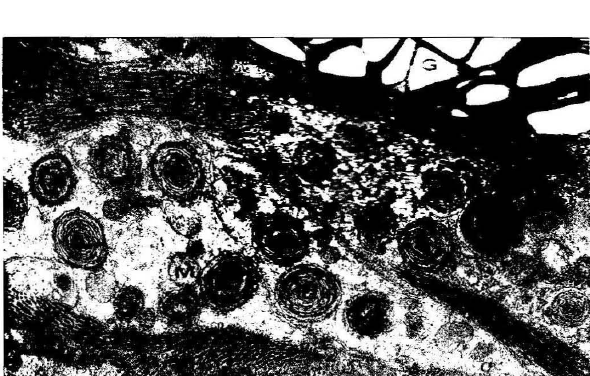
Figure 1. Electron microscopic picmre of chromatophores in the derma of Rana esculenta: guanophore (G); light coloured pigment cell with specific pteridines-containing cytoplasmic strucmres-pterinosomes (Pt) composed of concentric lamellae; M-mitochondria; L-lipid drops (Hitachi electron microscope, X15,OOO).